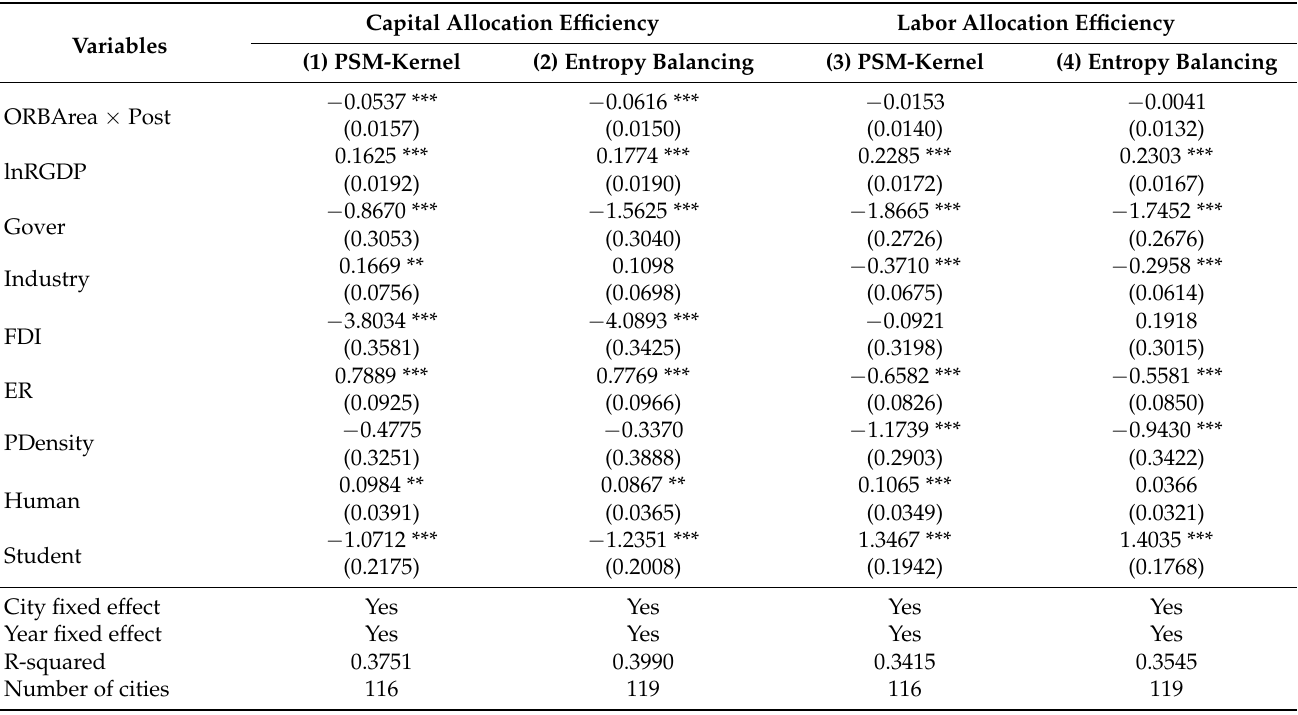
Table 7. Empirical results of factor allocation efficiency